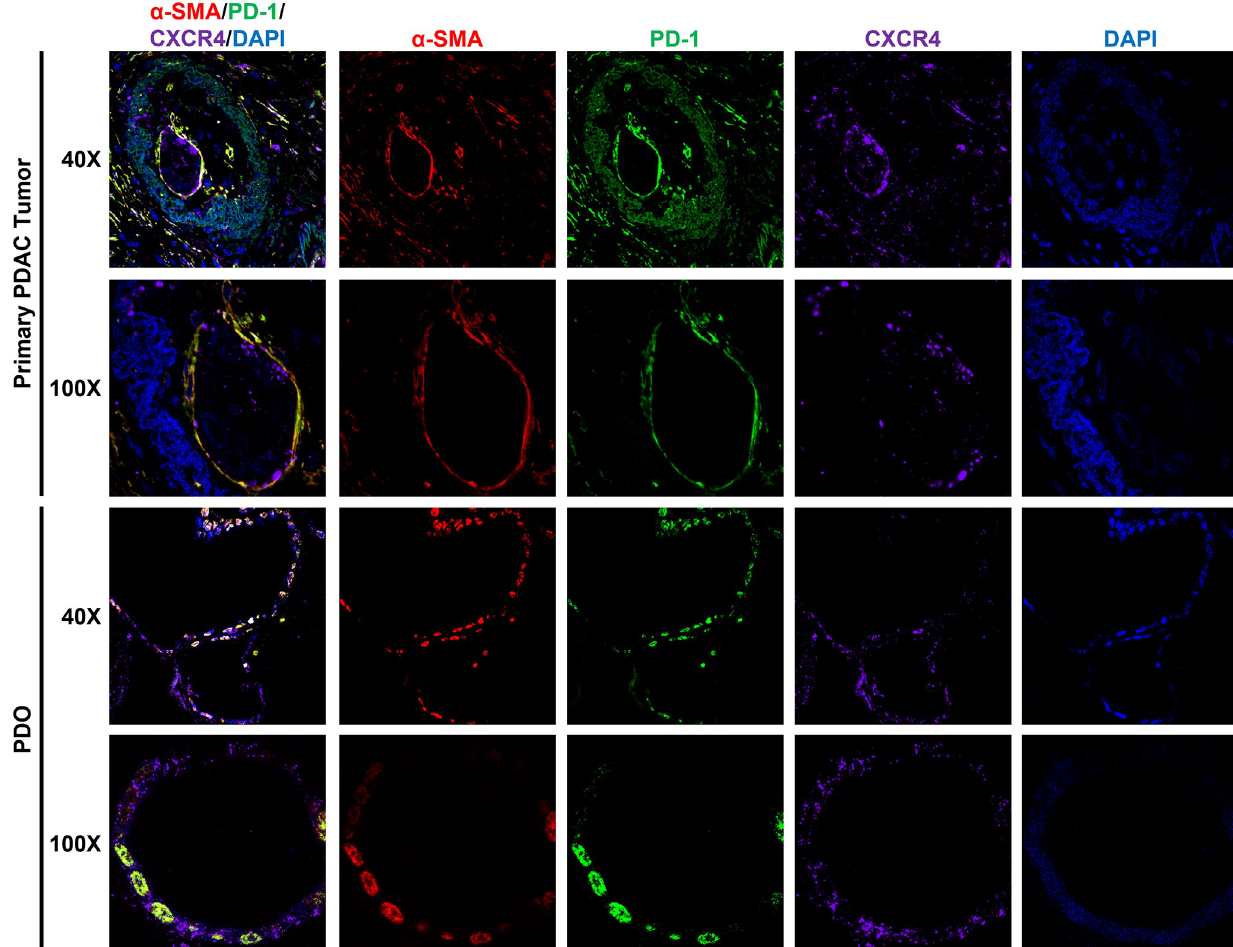
Fig 2. PD-1 and CXCR4 expression in PDAC tumors and PDOs. Operative human primary PDAC specimens and corresponding PDOs for hPT26 were serially sectioned and stained with multiplex IF. Both primary PDAC tissues and PDOs showed co-expression of PD-1 and CXCR4 ( green + violet ! teal ). These regions corresponded to areas consistent with pancreatic duct cells in primary PDAC tumors and PDOs. α -SMA was used as a marker for CAFs, which are known components of the PDAC TME that express PD-1 and CXCR4 ( red + green ! yellow, red + violet ! pink, red + green + violet ! white ). In primary tumors, CAFs with PD-1 and CXCR4 expression were predictably in regions of desmoplasia characteristic of the TME. α -SMA+ CAFs were similarly noted in areas typical of the TME in PDOs, along the periphery of the 3D organoid structures. Altogether, these results show concomitant expression of PD-1 and CXCR4 in human